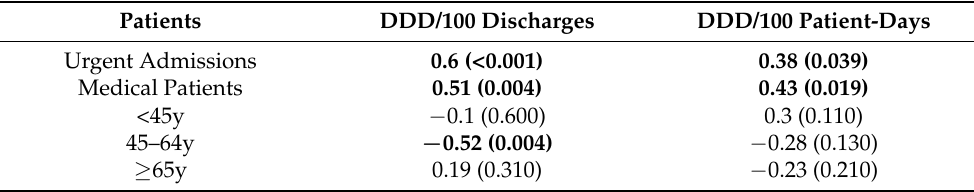
Table 1. Correlation coefficients between population characteristics and total antibacterial